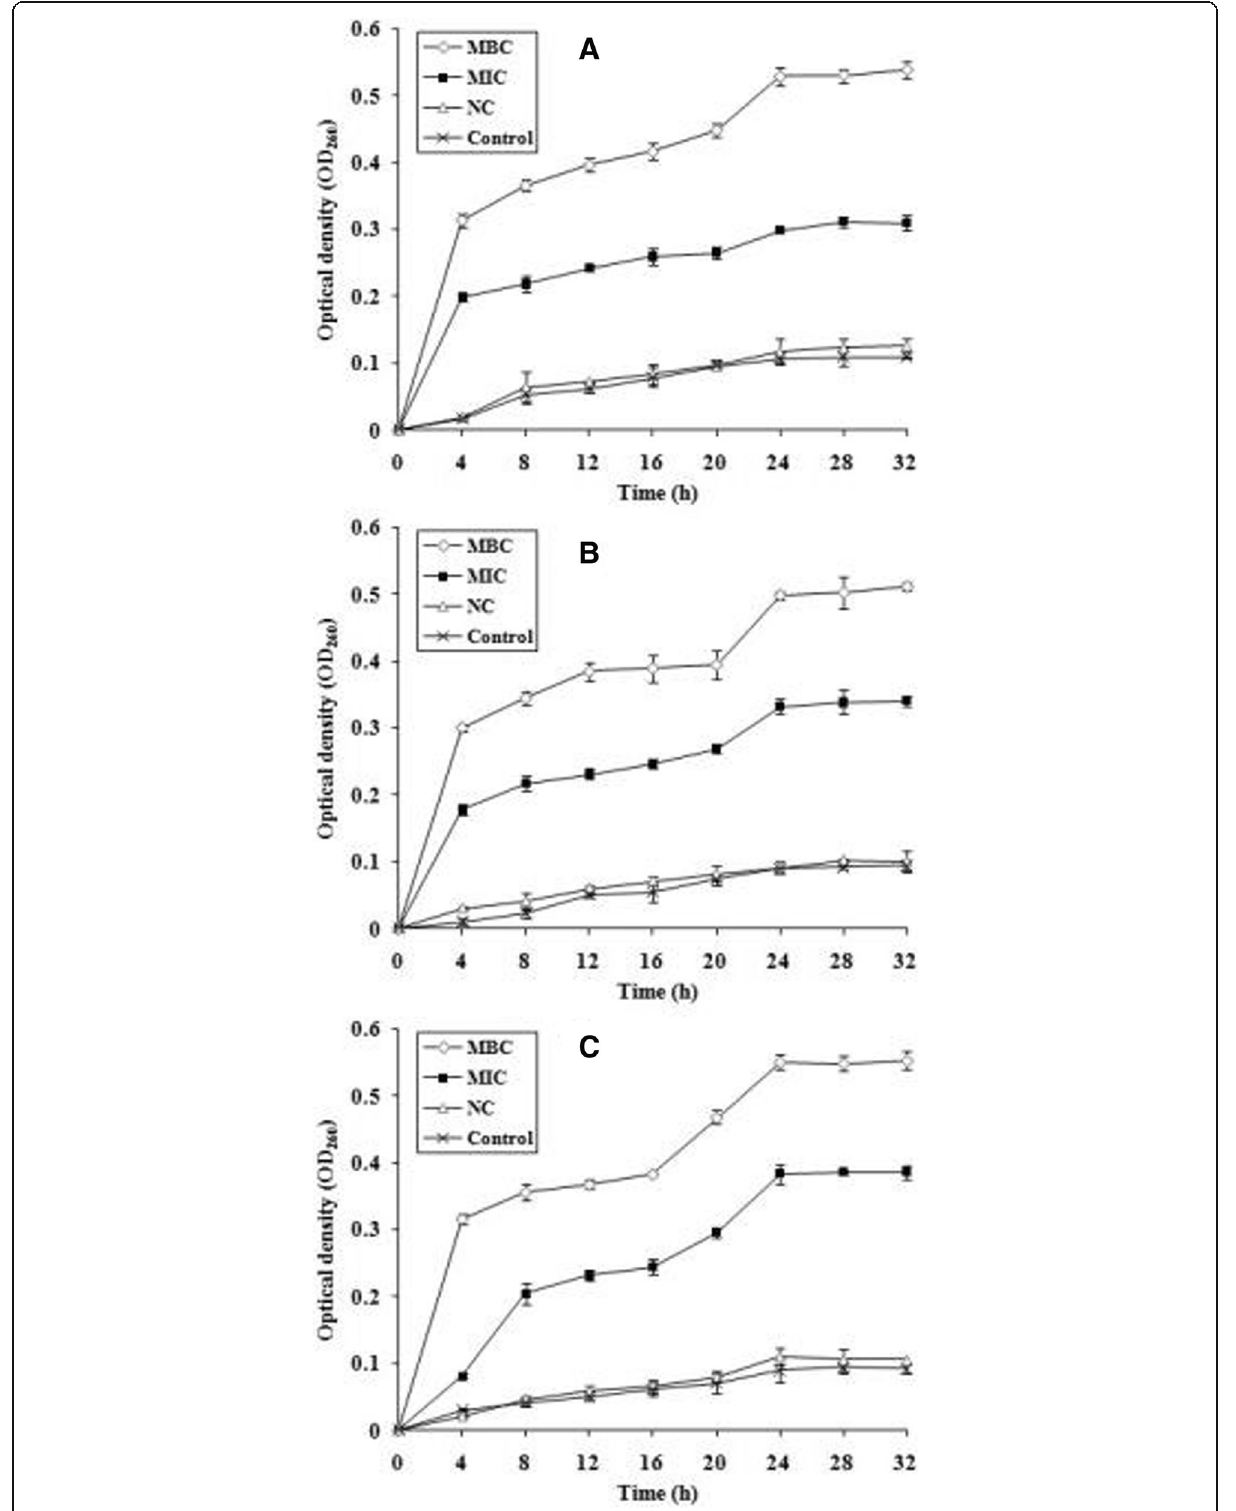
Fig. 3 Release of 260-nm absorbing material from P. gingivalis ( a ), C. perfringens ( b ), and F. nucleatum ( c ) treated with ATS-80 for 32 h. ATS-80, 80% methanol-eluted fractions from alkali-treated quinoa saponin; MBC, minimum bactericide concentration; MIC, minimum inhibition concentration; NC, negative control (quinoa